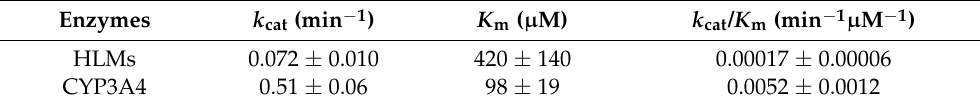
Table 1. Kinetic parameters of OA hydroxylation by CYP3A4.